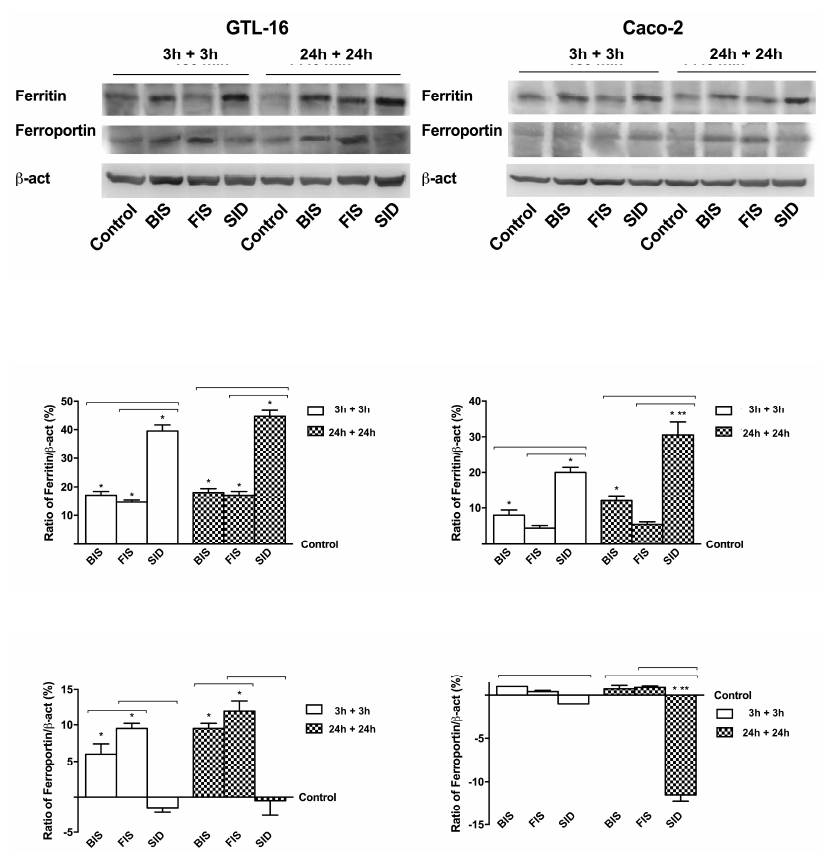
Figure 8. Western blot and densitometric analysis of ferritin light chain and ferroportin expressed on GTL-16 and Caco-2 cells maintained for equal time (3 h plus 3 h; 24 h plus 24 h) without iron treatments. Western blot (upper) and densitometric analysis (down) are reported. The results obtained after normalization through β -act and then through control values, are expressed as a means ± SD (% vs. control) of four independent experiments for each cell type. * p < 0.05 vs. control; ** p < 0.05 vs. correspondent column at different times; bars p < 0.05 among different treatments at the same